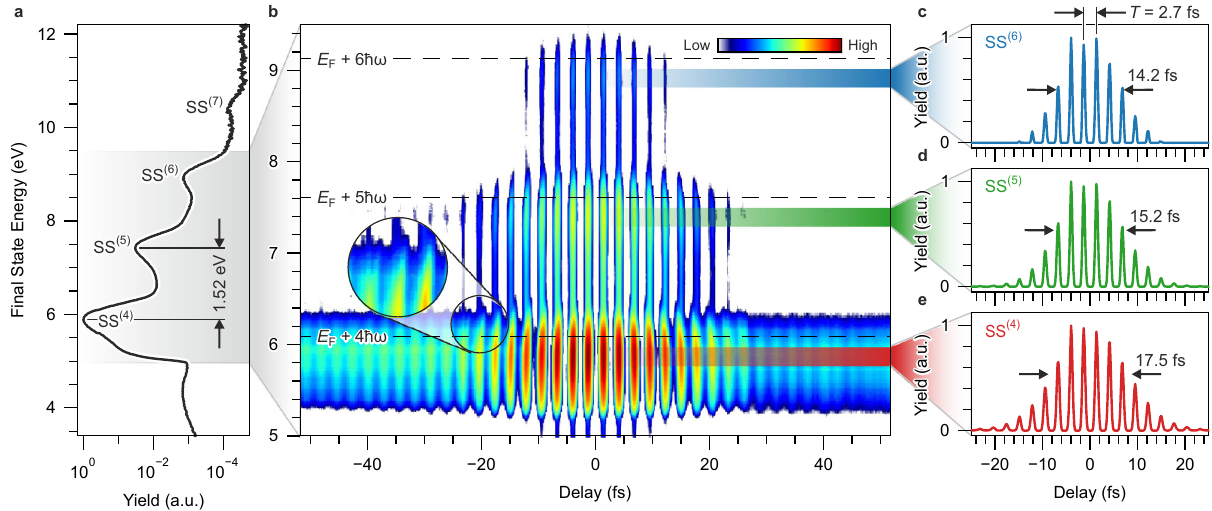
Fig. 3 Interferometric time-resolved plasmoemission spectroscopy. a High dynamic range electron spectrum showing up to 7 th order above-threshold electron emission from the Shockley surface state (SS) on Au(111) triggered by a surface plasmon polariton (SPP) nano-focus in an Archimedean spiral. b Interferometric time-resolved plasmoemission spectra presented in a logarithmic false-color scale (see color bar in panel b ) showing the dynamics of the electron emission process up to 6 th order. The Fermi edges at E F + n ℏ ω for the different electron emission orders n are indicated by the black dashed lines, where ℏ ω = 1.52 eV is the SPP energy. c – e Line-pro fi les through the data in panel b extracted at the 6 th to 4 th order SS replica, respectively, by integration over an energy range of ≈ 200 meV for each peak. The arrows indicate the full widths at half maximum (FWHMs) of the envelopes of the line-pro fi